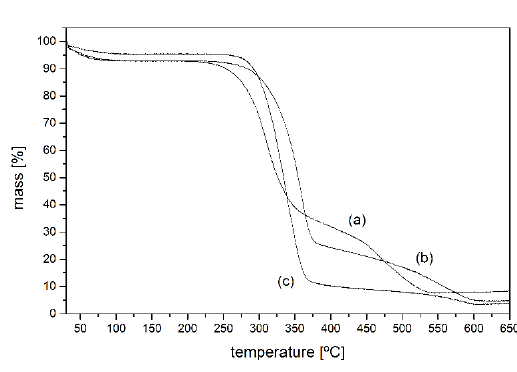
Figure 5. TG curves corresponding to: raw bark of Cereus Forbesii (a), cellulose obtained by alkaline treatment (b), and cellulose nanofibers obtained by the acid hydrolysis of cellulose (c). All curves show a small weight loss associated with the evaporation of water (dehydration) between room temperature and 100ºC. The thermal decomposition of all samples shows weight losses that resulted in a final ash residue. Such residue is formed from 550°C for the raw bark (curve “a”), and from 600ºC for the samples of cellulose and cellulose nanofibers (curves “b” and